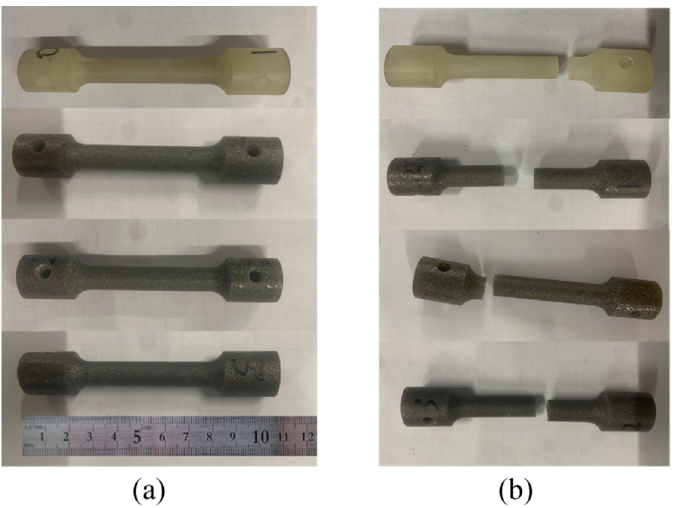
Figure 7. Diagram of tensile loading process of foam Ni-Fe/epoxy composite: ( a ) original specimen; ( b ) damaged specimen.